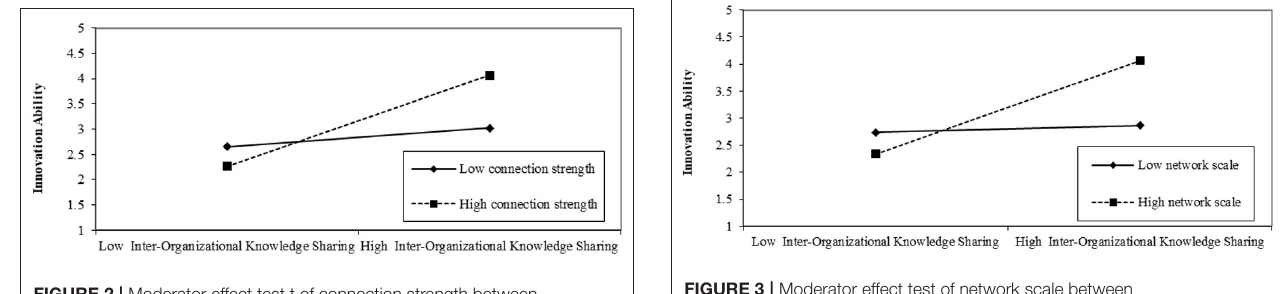
FIGURE 2 | Moderator effect test t of connection strength between inter-organizational knowledge-sharing and innovation capability.